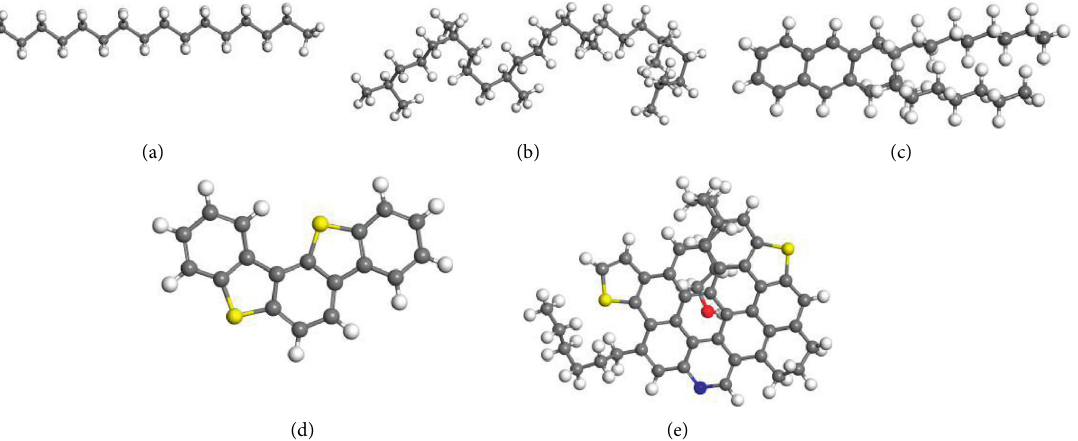
Figure 2: Molecular structure of each component in the low-sulfur fuel oil (carbon: grey, hydrogen: white, sulfur: yellow, and oxygen: red). (a) Hexadecane. (b) Saturate. (c) Aromatic. (d) Resin. (e)